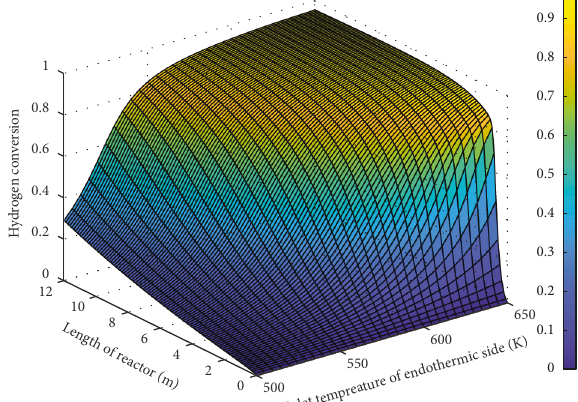
Figure 6: Effect of temperature on the exothermic side of the reactor on conversion percentage of 2-butyl alcohol and MEK yield.